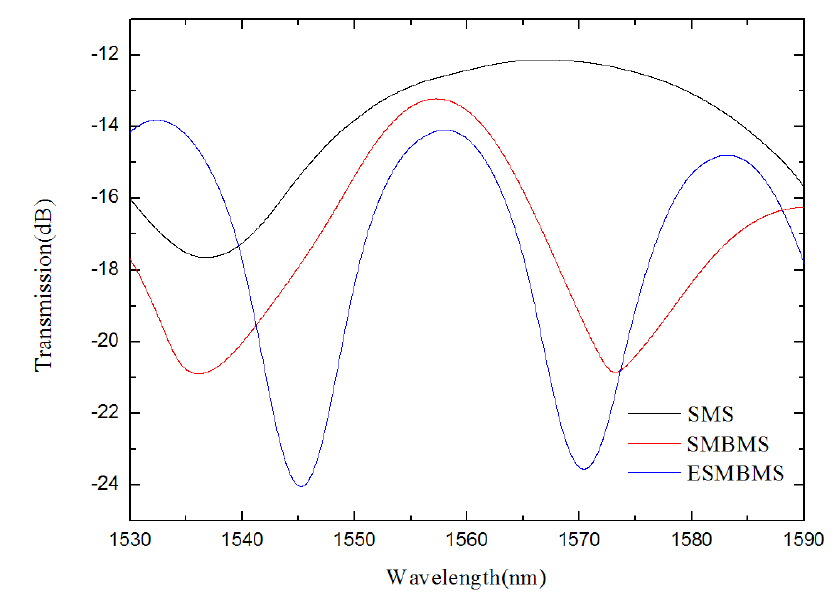
Figure 9. Measured transmission spectra with different L. According to the transmission spectrum, the higher-order mode is found, and the frequency spectrum obtained after Fourier transform is shown in Figure 10. The main peak amplitudes are located at 0.0199164 nm − 1 , 0.0300104 nm − 1 , and 0.0412538 nm − 1 .